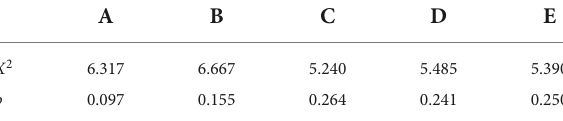
TABLE 3 Chi-square test of preference of musician and non-musician subjects for audio material